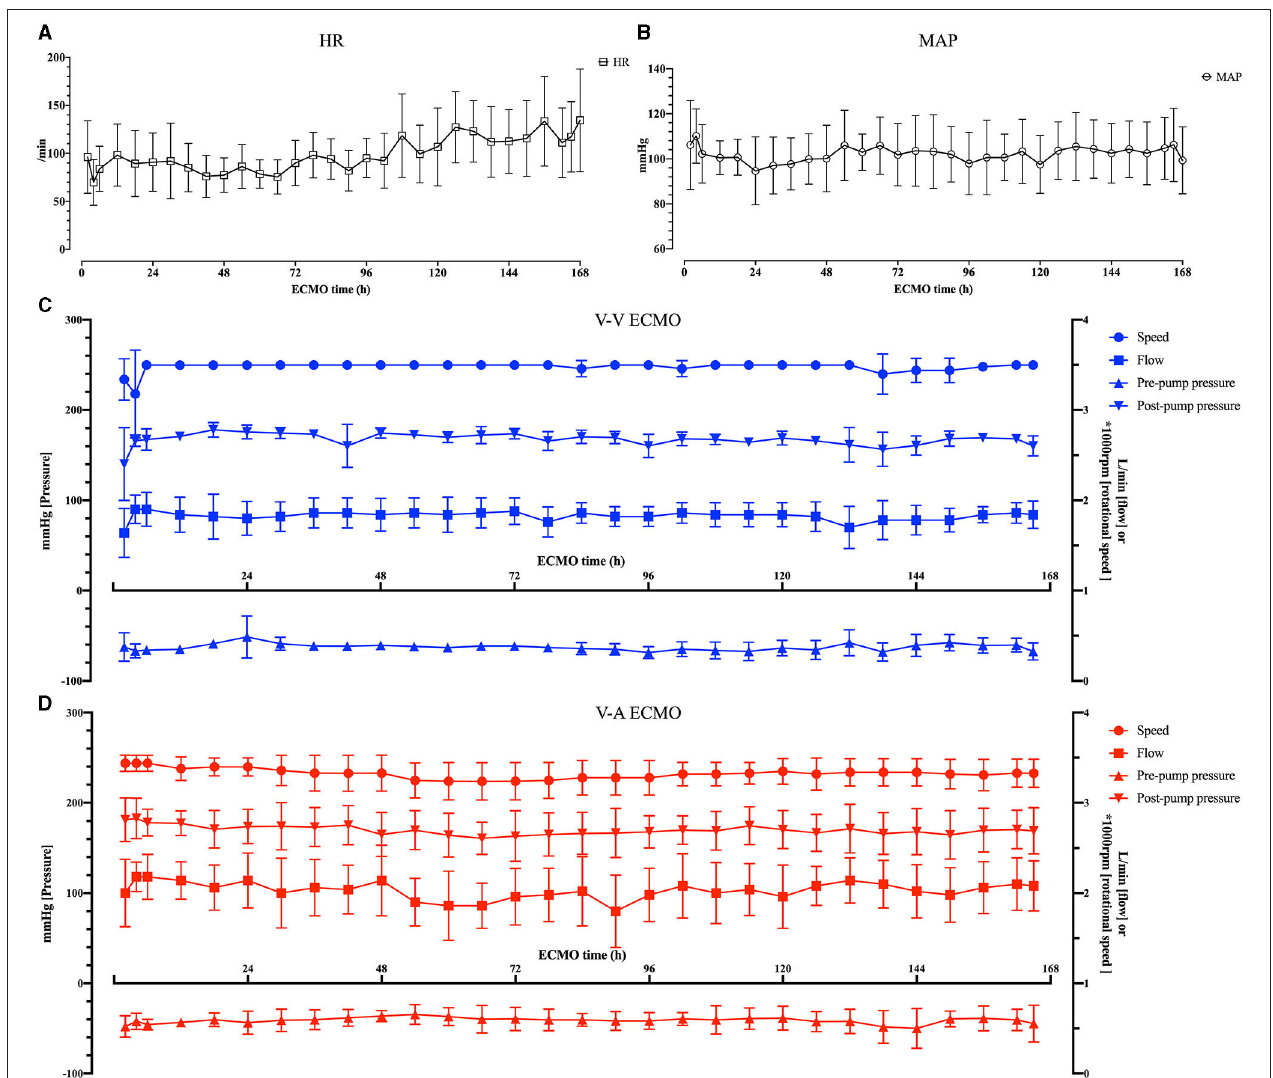
FIGURE 4 | The vital signs of the sheep and the ECMO configurations. (A) The heart rate (HR) of the sheep. (B) The mean arterial pressure (MAP) of the sheep. (C) The rotational speed, flow, pre-pump pressure and post-pump pressure of the OASSIST ECMO system in the V-V group. (D) The rotational speed, flow, pre-pump pressure and post-pump pressure of the OASSIST ECMO system in the V-A